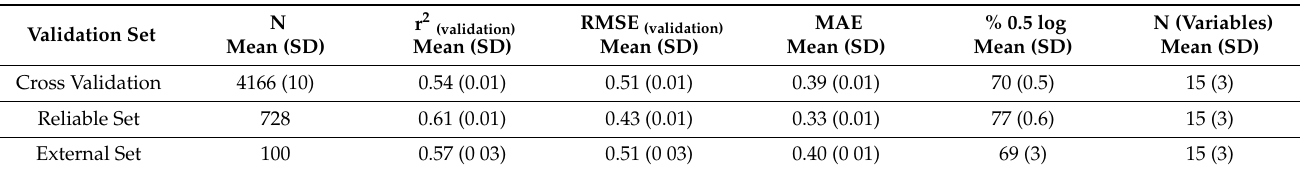
Table 1. Validation metrics of conditional consensus model. Statistics: r 2 , r-squared of validation; RMSE, root mean squared error; MAE, mean absolute error; and % 0.5 log, percentage of molecules within the 0.5 log of prediction